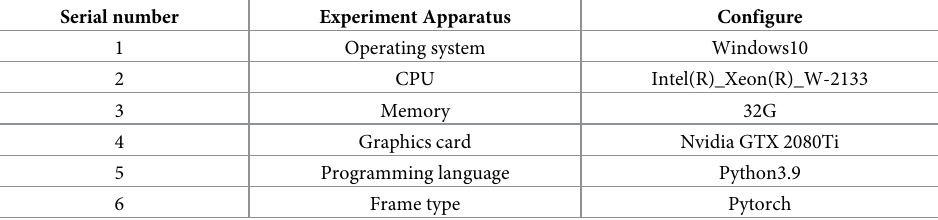
Table 1. Hardware information of simulation experiment.